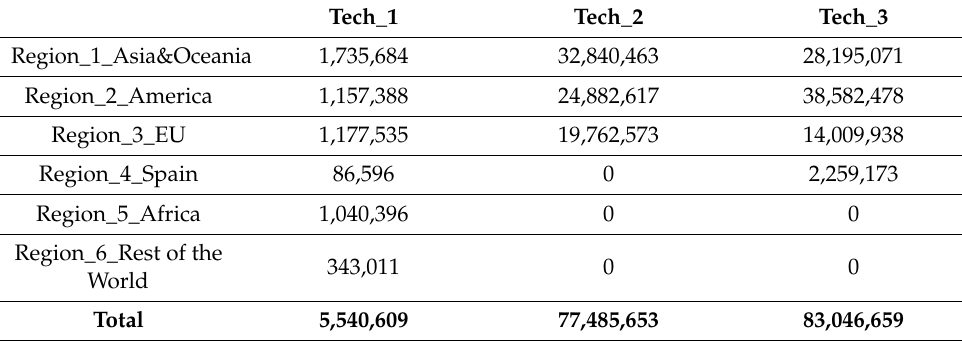
Table 15. f2 + no bot constraints. Solution of x by region and technology (million $).